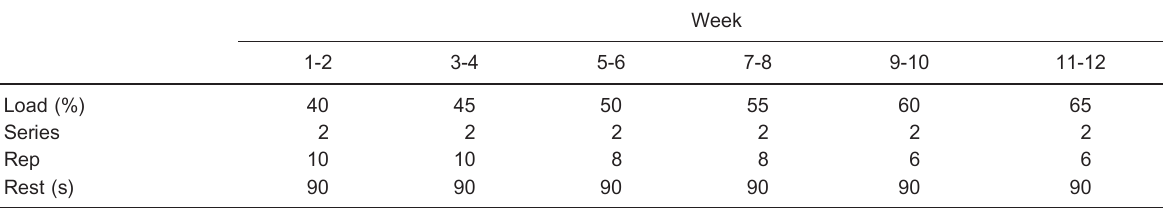
Table 1. Characteristics of the resistance circuit training, comprised of 6 stations, performed by participants in the exercising